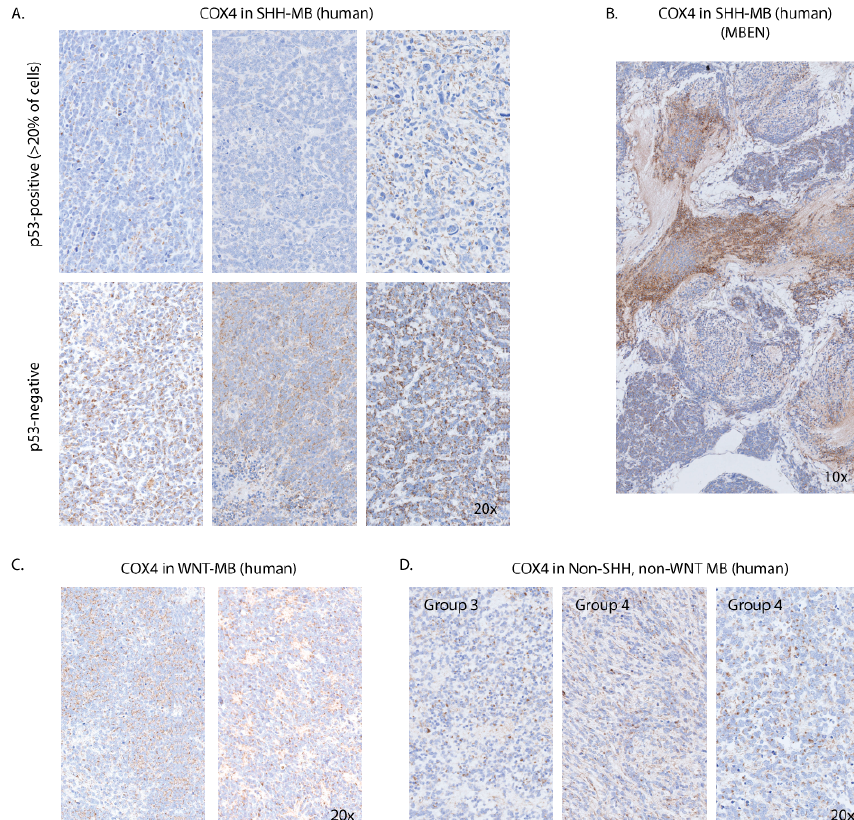
Figure 9. COX4 is highly expressed in a subset of human SHH-MB. Sections of FFPE tumor samples were stained with the anti-COX4 antibody (brown) and counterstained with hematoxylin (blue). Images were scanned at an original magnification of 40 × . Digital magnification is 20 × for all images except MBEN-type SHH-MB ( B ). ( A ) COX4 in primary SHH-MB tumors according to p53 status. ( B ) MBEN-type SHH-MB showing strong COX4 immunoreactivity in the internodular region imaged at 10 × physical magnification. ( C ) WNT-MB tumors imaged at 20 × physical magnification. ( D ) Non-SHH-, non-WNT-type tumors imaged at 20 × magnification. The molecular subgroup is indicated for each sample.